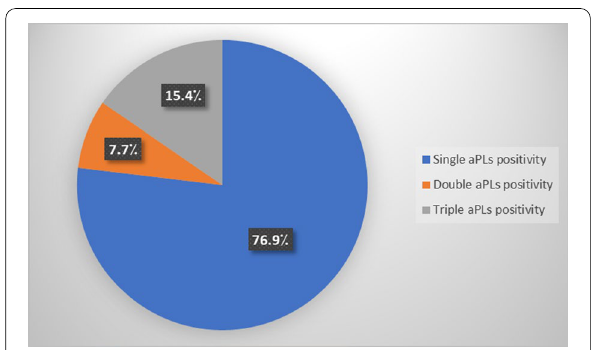
Fig. 1 Serological positivity of different screened autoantibodies among PAPS